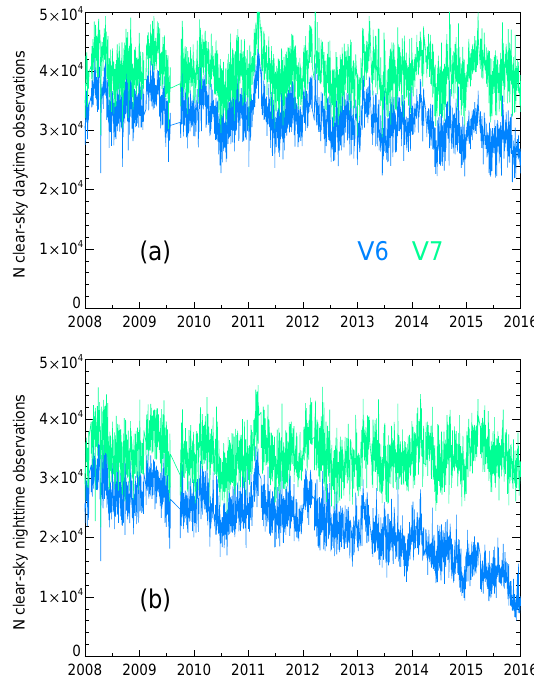
Figure 2. Time series comparisons of (a) daytime and (b) nighttime daily number of clear-sky MOPITT observations over the ocean be- tween 30 ◦ S and 30 ◦ N for the V6 and V7